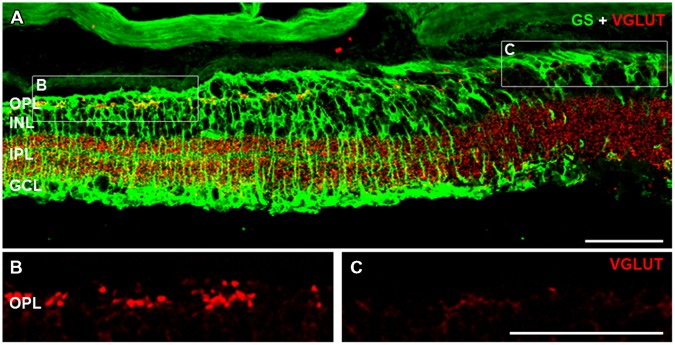
Cone photoreceptor loss is evident in areas containing aberrant Müller cells. Vertical sections of 6 month-old rd1-FTL retinae were double labeled for VGLUT1 (red) and GS (green) in order to investigate the presence of cone photoreceptor terminals in FTL-rich regions. VGLUT1 immunolabeling is expressed in the OPL and IPL (A). High magnification of the OPL shows that in regions where GS is expressed, cone photoreceptor terminals remain (B), however, in areas of low to no GS (C), VGLUT expression is absent. Abbreviations: OPL, outer plexiform layer; INL, inner nuclear layer; IPL, inner plexiform layer; GCL, ganglion cell layer. Scale bar: 50 μm.